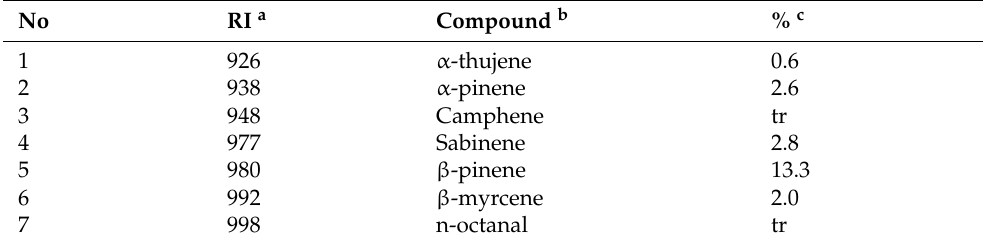
Table 2. Chemical composition of essential oil from Citrus limon